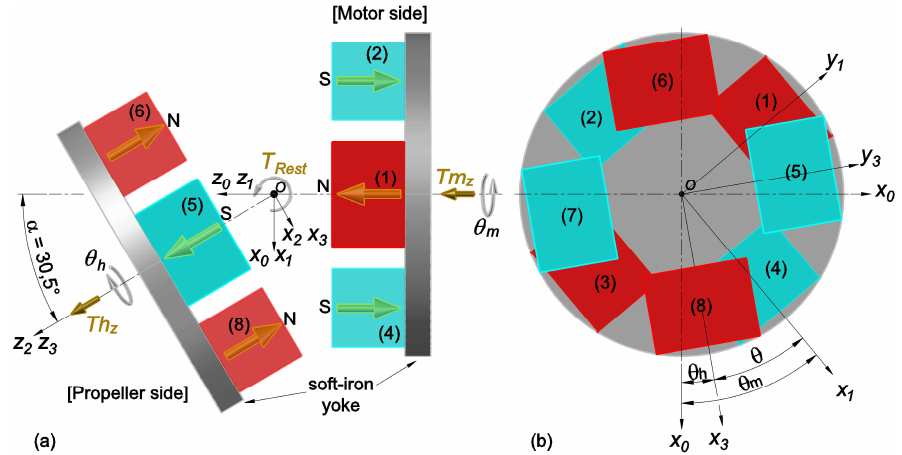
Figure 3. Flat-RMCT plan views: ( a ) side view with α max and θ = θ m = θ h = 0 ◦ . ( b ) front view without the propeller soft-iron yoke, with α = 0 ◦ , θ > 0 ◦ , θ m > 0 ◦ , θ h > 0 ◦